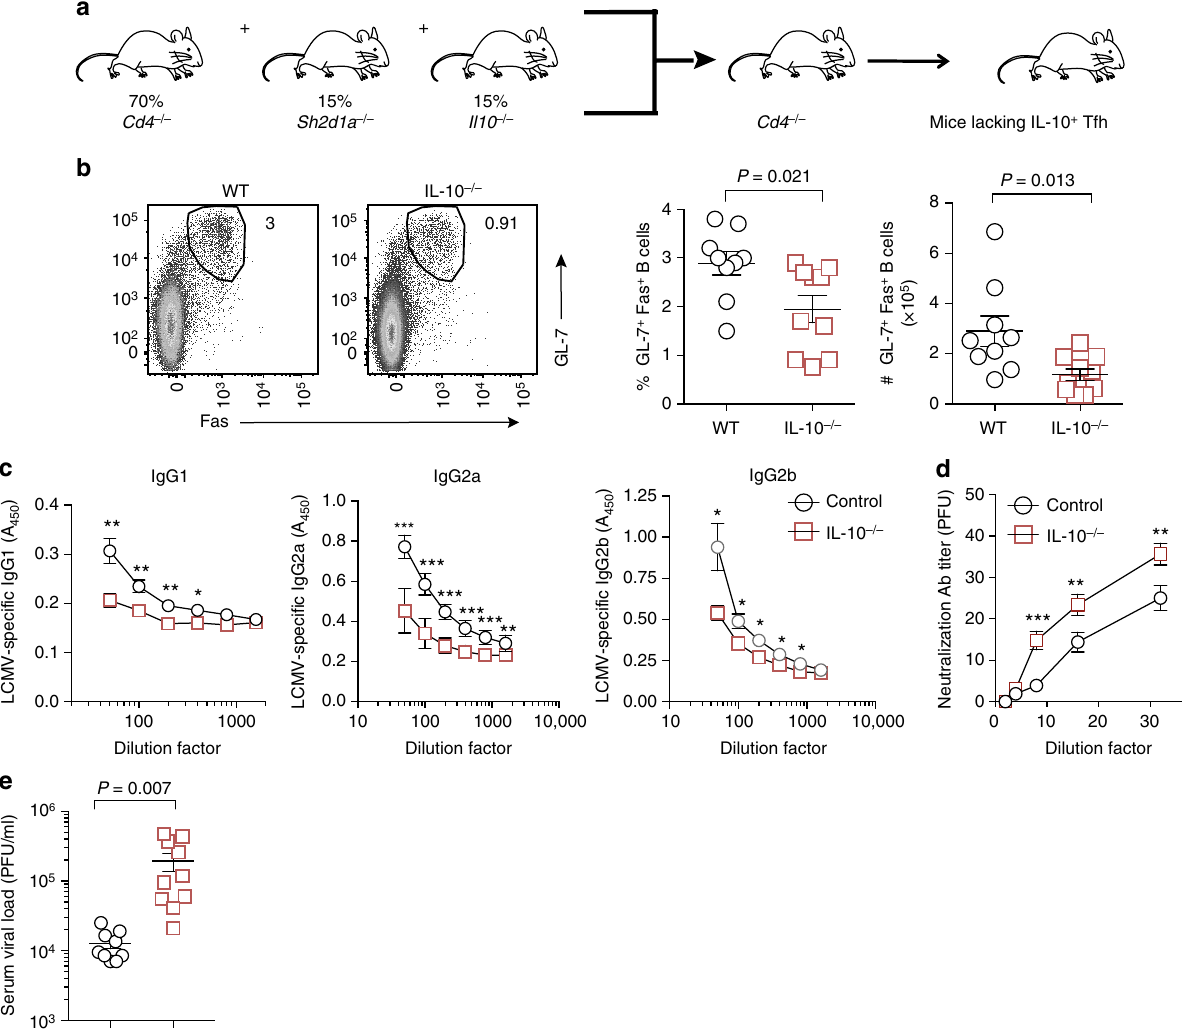
Fig. 4 Tfh-derived IL-10 sustains antiviral humoral immunity. a Experimental scheme of generating MBM chimeric mice with Tfh-speci fi c IL-10 deletion. b – e WT and Il10 − / − Tfh MBM chimeric mice were infected with LCMV Cl13. On day 21 p.i., GC reactions and antibody responses were examined. b Representative fl ow plots (left) and scatter graphs (right) showing the frequency and total number of GC B cells from WT and Il10 − / − Tfh MBM chimeric mice. c Summary graphs showing serum levels of LCMV-speci fi c IgG1, IgG2a, and IgG2b. d Summary graph showing relative antibody neutralization